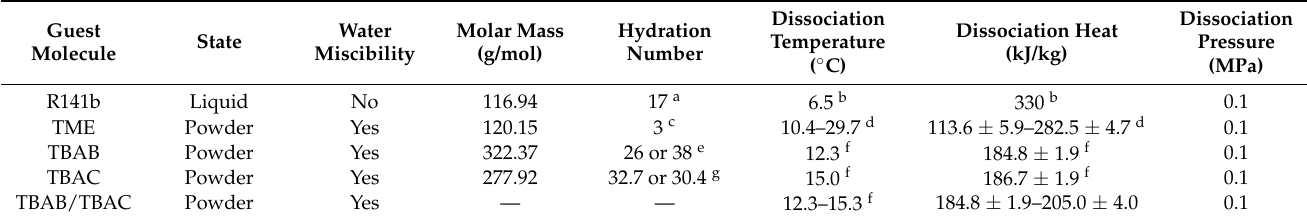
Table 1. Properties of the guest molecules.